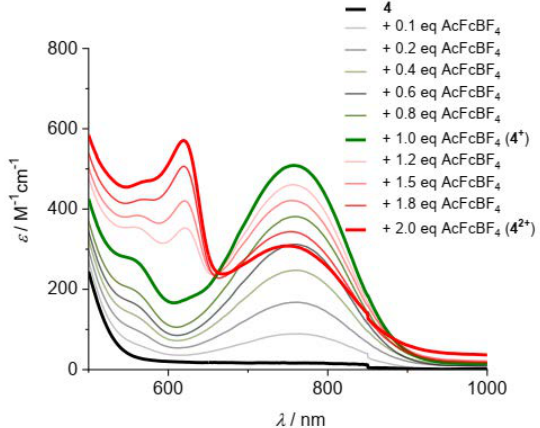
Figure 9. Visible absorption spectra in CH 2 Cl 2 /0.1 M n Bu 4 NPF 6 of 4 obtained by oxidation of the neutral parent compound with up to 1 equivalent of ferrocenium[BF 4 ] followed by stepwise addition of a second equivalent of acetylferrocenium[BF 4 ]; c = 0.5